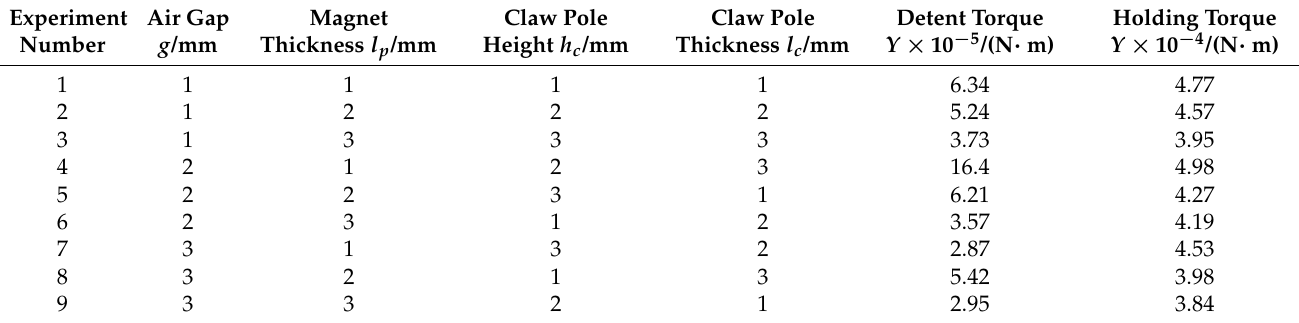
Table 3. L 9 [ 3 4 ] orthogonal array